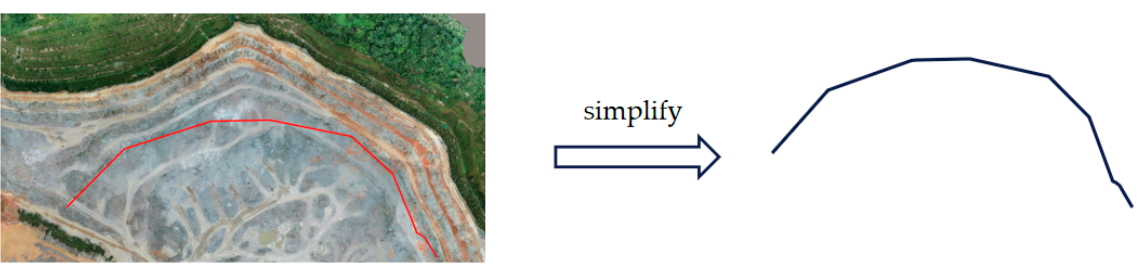
Figure 5. Observation coverage in the Z-direction. ( a ) The case where a single camera can cover the Z-direction of the slope of the open-pit mine, where a single camera is deployed on the right, with the dashed line showing the range of shots and the black curve showing the Z-direction of